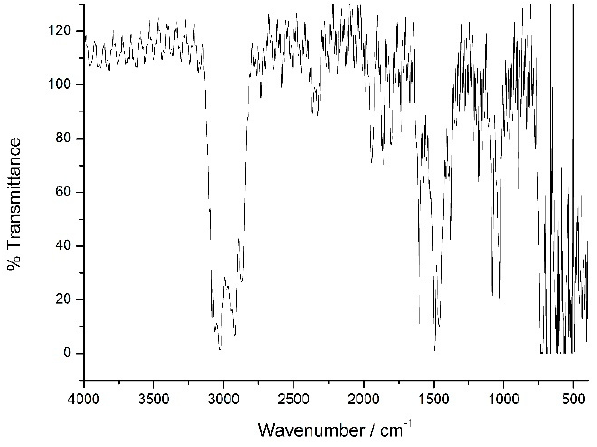
Figure 2. Transmittance in the infrared spectrum of Toluene at 298.15 K and 101.3 kPa. The typical response curve for the injection of toluene in supercritical carbon dioxide is represented in Figure 3. It is possible to identify three peaks for toluene in supercritical CO 2 , by following the absorbance of the flow at the upper defined wavenumbers. The response curves show no peak tailing effects (their gaussian shape is symmetrical). Moreover, we have one response signal at wavenumber, 2100 cm − 1 , where absorption is minimum. The latter provides reference on the stability of the experiment, giving us the reading of a baseline signal, and it is noticeable that it remains stable during the